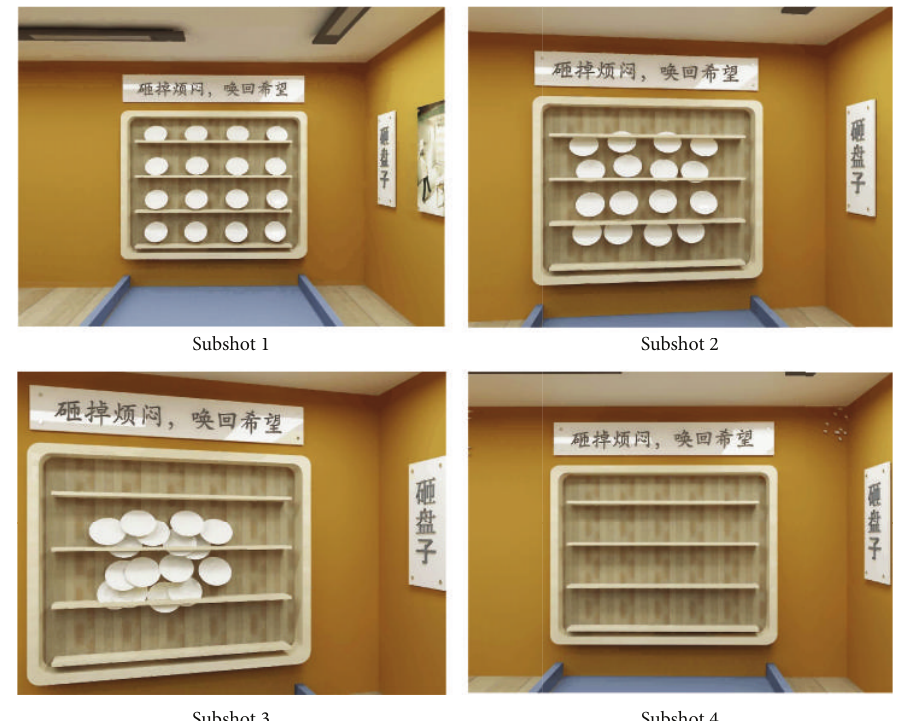
Figure 7: Key-frames extracted from Broken